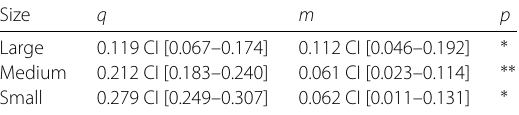
Table 2 Bootstrap results for weekends. The table reports the mean values of intercept q and slope m for 500 bootstrap iterations. The bootstrapped 95% Confidence Intervals (CI) and the p -value p for the t-test on the slope m ( p ≤ 0.05: ∗ , p ≤ 0.01: ∗∗ , p ≤ 0.001: ∗∗∗ ) are also